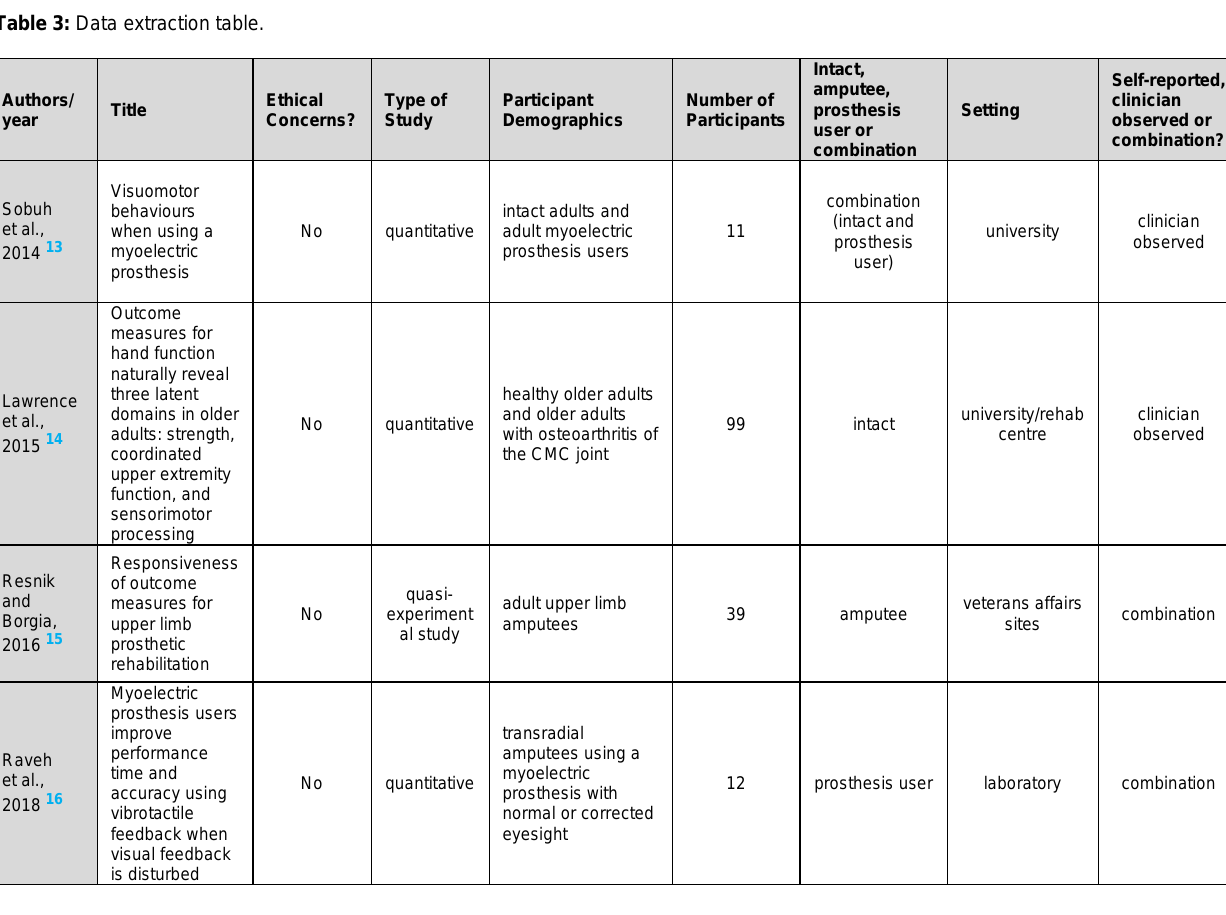
Table 3: Data extraction table.